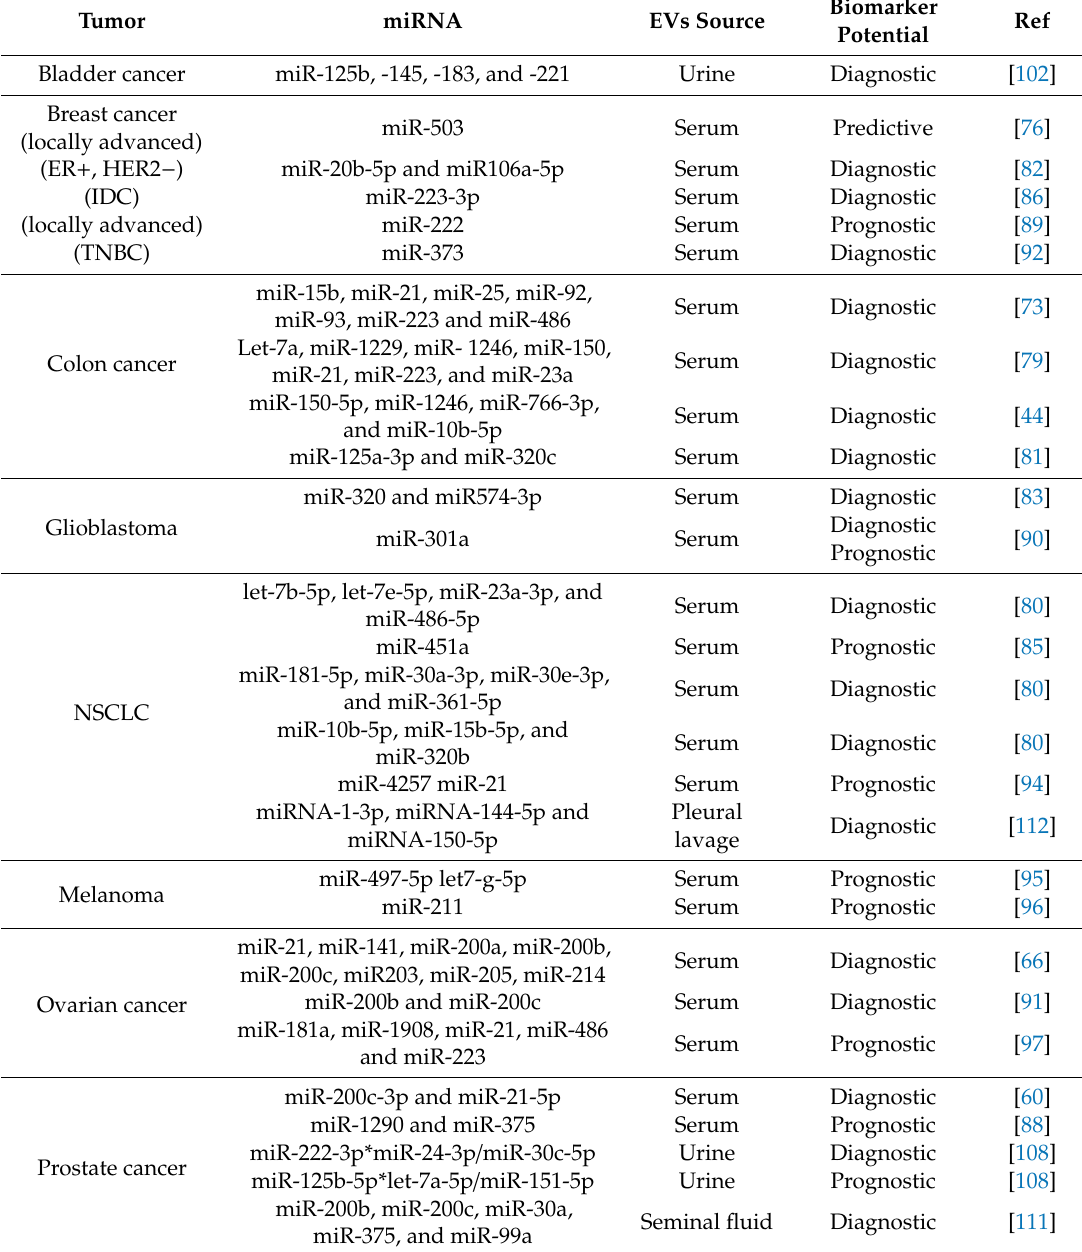
Table 2. EV-associated miRNAs as biomarkers for cancer diagnosis and